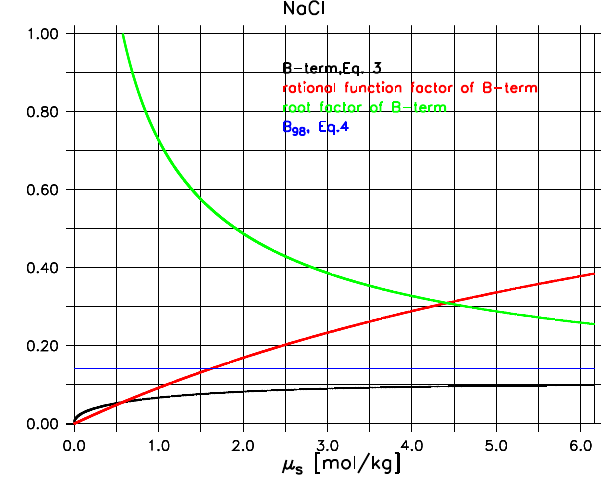
Fig. 7. A-term and its linear and bell shaped (or Gaussian) curve for NaCl.